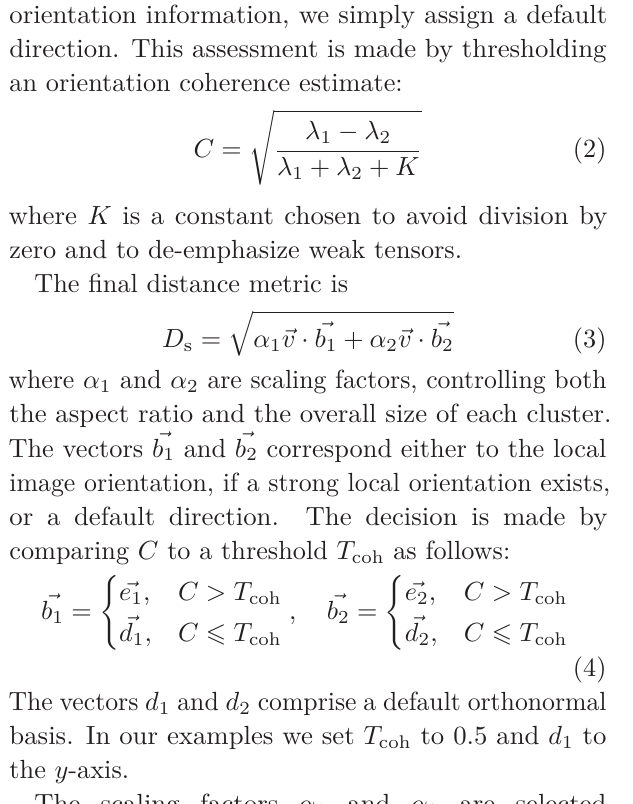
Fig. 6 High-resolution pebbles rendered at 5 times the input resolution. Left: pebble shapes. Right: 3D rendered